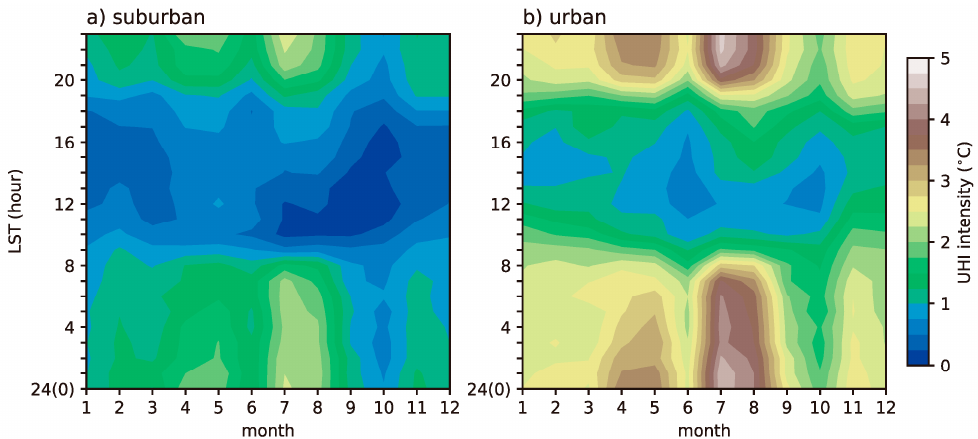
12 of 18 Figure 7. ( a ) Correlations between UHI intensity (°C) and mean rural cooling rate during early evening transition (EET) (°C /hour). Red and blue dots indicate urban and suburban sites, respectively. ( b ) Correlations between UHI intensity and mean rural heating rate during early morning. 4. Seasonal Variations of UHI Intensity Figure 8 shows the mean UHI intensity at urban and suburban sites as a function of month and time of the day. It is found that at a certain time of the day, the UHI intensity shows a notable warm– cold season contrast at both urban and suburban areas. However, throughout the year, the timing of the strongest UHI intensity always occurs at around midnight (00 LST). Thus, for a better illustration on seasonal variations, the UHI intensity at midnight is analyzed. The results are shown in Figure 9a. A prominent warm–cold contrast of UHI intensity is detected, which is similar to other cities (e.g.,